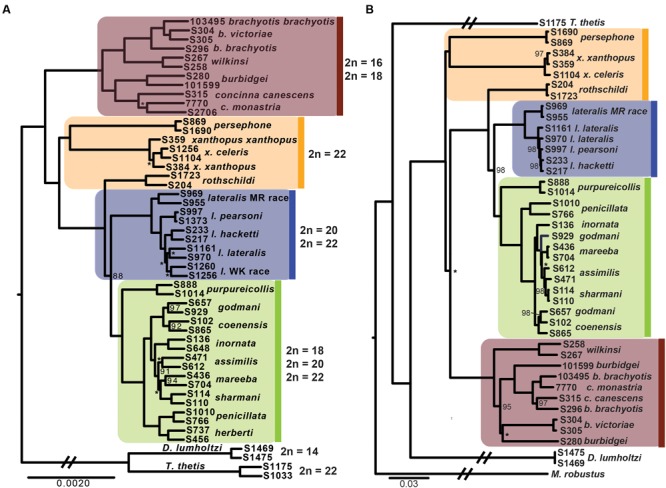
(A) Phylogenetic relationships of rock-wallabies (Petrogale) based on a maximum likelihood analysis of concatenated nuclear data (1961 loci). Bootstrap support < 100% is outlined on the nodes, ∗ = < 50%; nodes with neither have support of 100%. Four chromosomal groups are highlighted on the phylogeny: the brachyotis group = red; the xanthopus group = yellow; the lateralis group = blue; and the penicillata group = green. Karyotype variation (2n) for each of the four chromosomal groups is highlighted. Dendrolagus lumholtzi (tree kangaroo) and Thylogale thetis (pademelon) are used as outgroups. (B) A maximum likelihood mitochondrial phylogeny of Petrogale based on all mitochondrial coding genes (12 loci). Chromosomal groups are highlighted to match (A), as is bootstrap support.